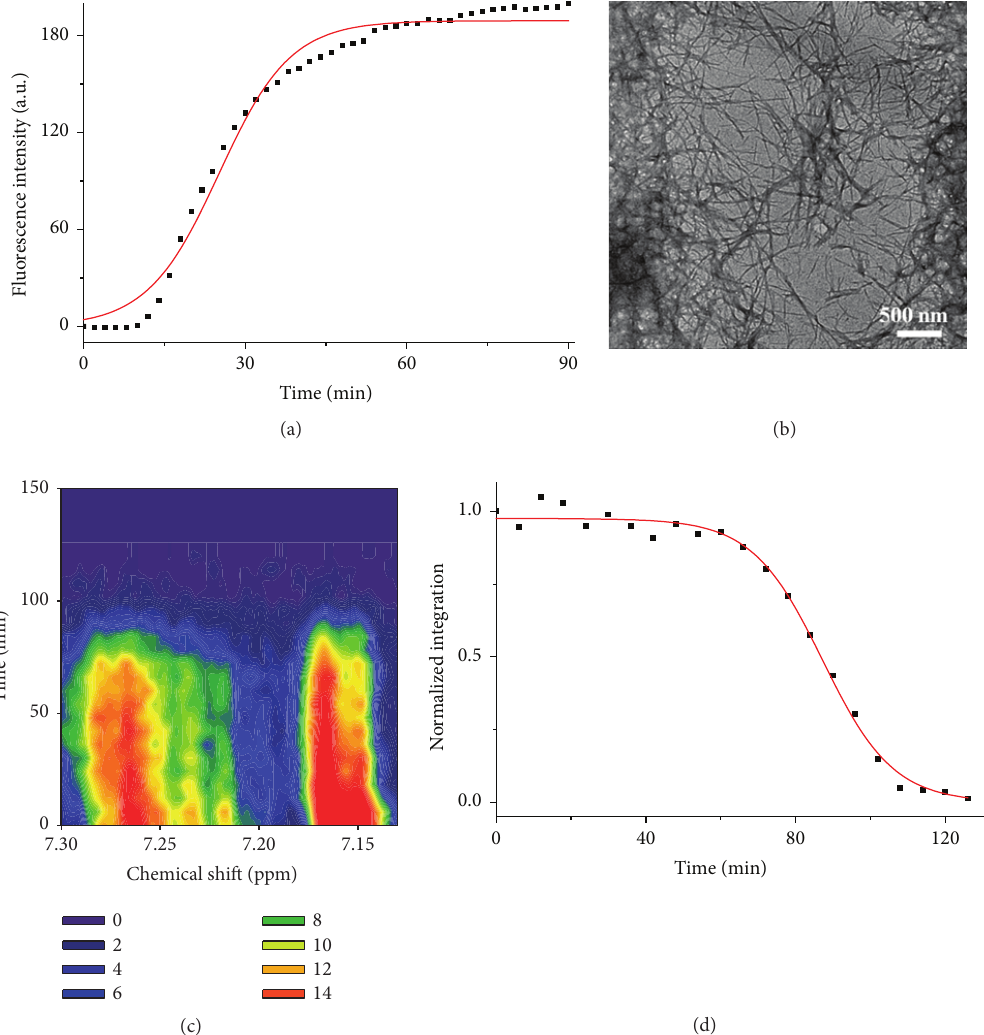
Figure 4: Self-aggregation of hIAPP. (a) Fibrillation kinetics of 16 𝜇 M hIAPP in 20mM PBS at pH 7.4 under 37 ∘ C monitored by ThT fluorescence. The values represent mean ( 𝑛 = 3 ). Solid lines represent the curves fitted using (1). (b) TEM image of 16 𝜇 M hIAPP incubated in 20mM PBS for 2h. (c) Contour plots of 1 H NMR spectra within chemical shift from 7.13 to 7.3ppm for 100 𝜇 M hIAPP incubated in 6 mM PBS at pH 7.4 and 25 ∘ C. (d) Aggregation kinetics of integrationresonanceintensity of 1 H NMR spectra from 7.13 to 7.3ppm for 100 𝜇 M hIAPP. Solid lines represent the curves fitted using (1). The integration values were normalized to the initial hIAPP alone